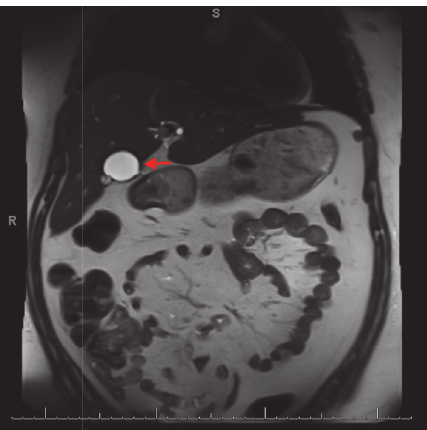
Figure 3: ERCP revealing a stone in the cystic duct (marked with arrow).